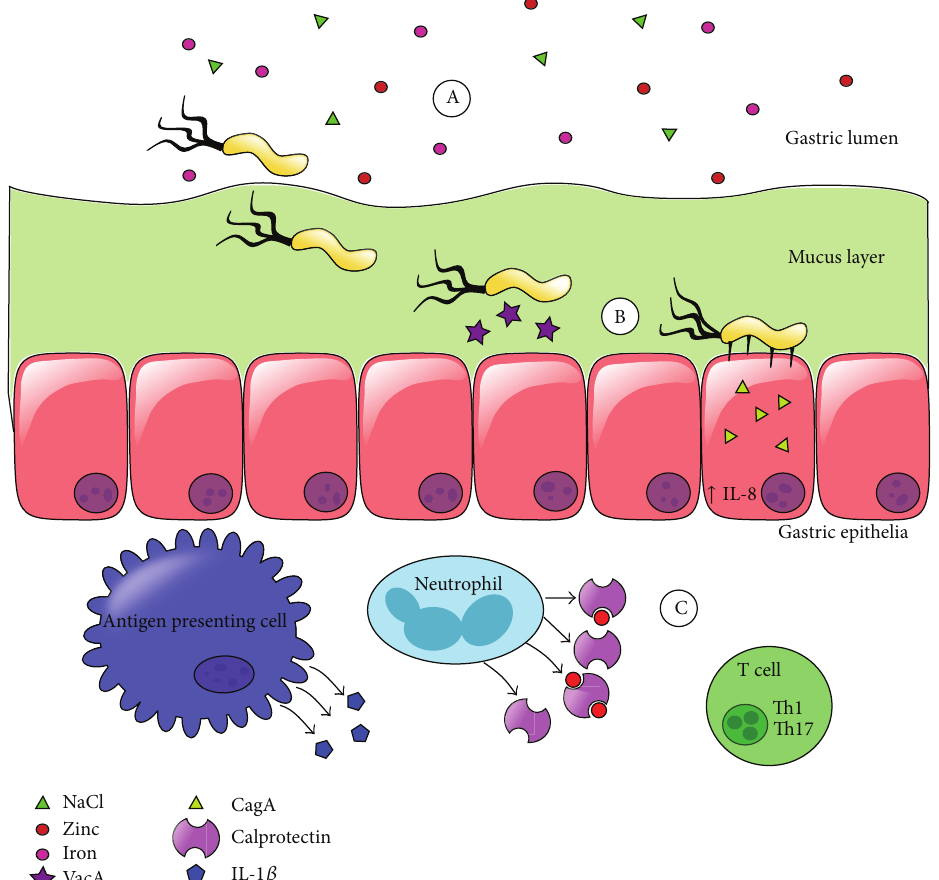
Figure 3: Model of H. pylori -host interaction in vivo . (A) H. pylori encounters numerous ions in the gastric niche and utilizes flagella to penetrate the mucus layer and reach the gastric epithelia. (B) H. pylori secretes VacA and CagA cytotoxins, causing changes in host cell biology. (C) The adaptive immune response as a consequence of H. pylori infection is skewed to expand Th1 and Th17